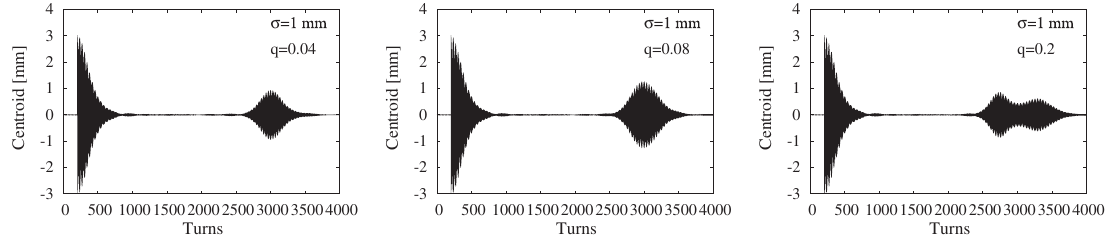
FIG. 3. Time evolution of the centroid after the dipole kick at turn 200, with different strength quadrupole kicks applied at turn 1600. The echo pulse is centered around turn 3000. Both the initial emittance (corresponding to σ 0 ¼ 1 mm at the BPM) and dipole kick ¼ 3 mm were kept constant. Quadrupole kicks increase from left to right in the three plots. The relative amplitude of the echo has a maximum at q ¼ 0 . 08 (center plot) at the chosen